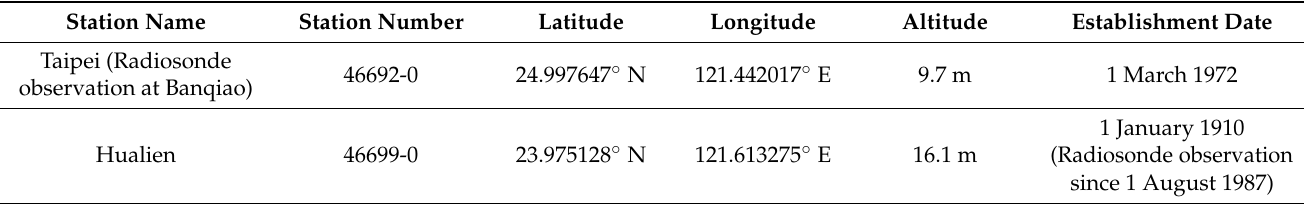
Table 2. Information of the studied CWB sounding stations listed in the order of station